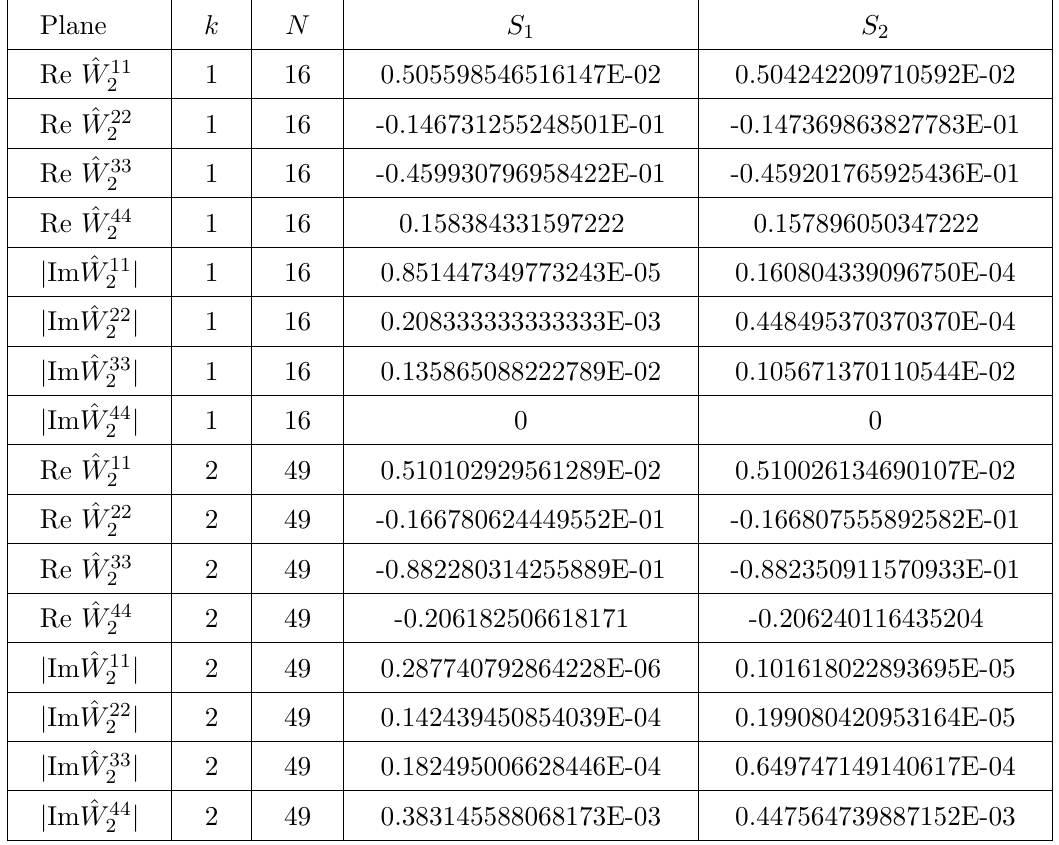
Table 3. Second order coe(cid:14)cients of the R (cid:2) R Wilson loops with R = 1 (cid:1) (cid:1) (cid:1) 4, for the TEK model and: N = 16 ( k = 1) and N = 49 ( k = 2). The coe(cid:14)cients have been computed with quadruple